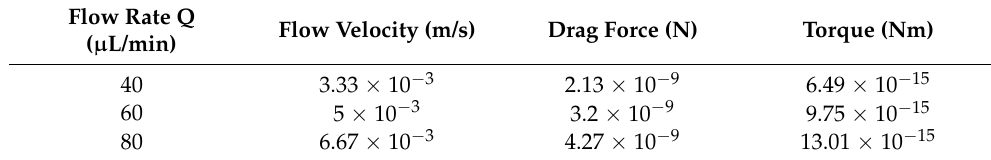
Table 2. Results of the fixed crystal simulation.